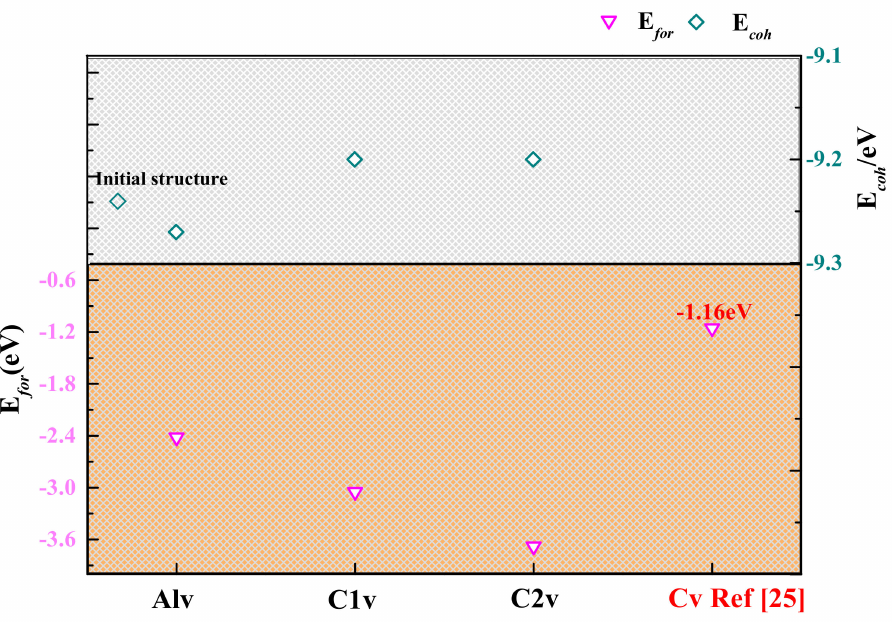
Figure 6. E coh and E for for H incorporation into different vacancies of Nb 4 AlC 3